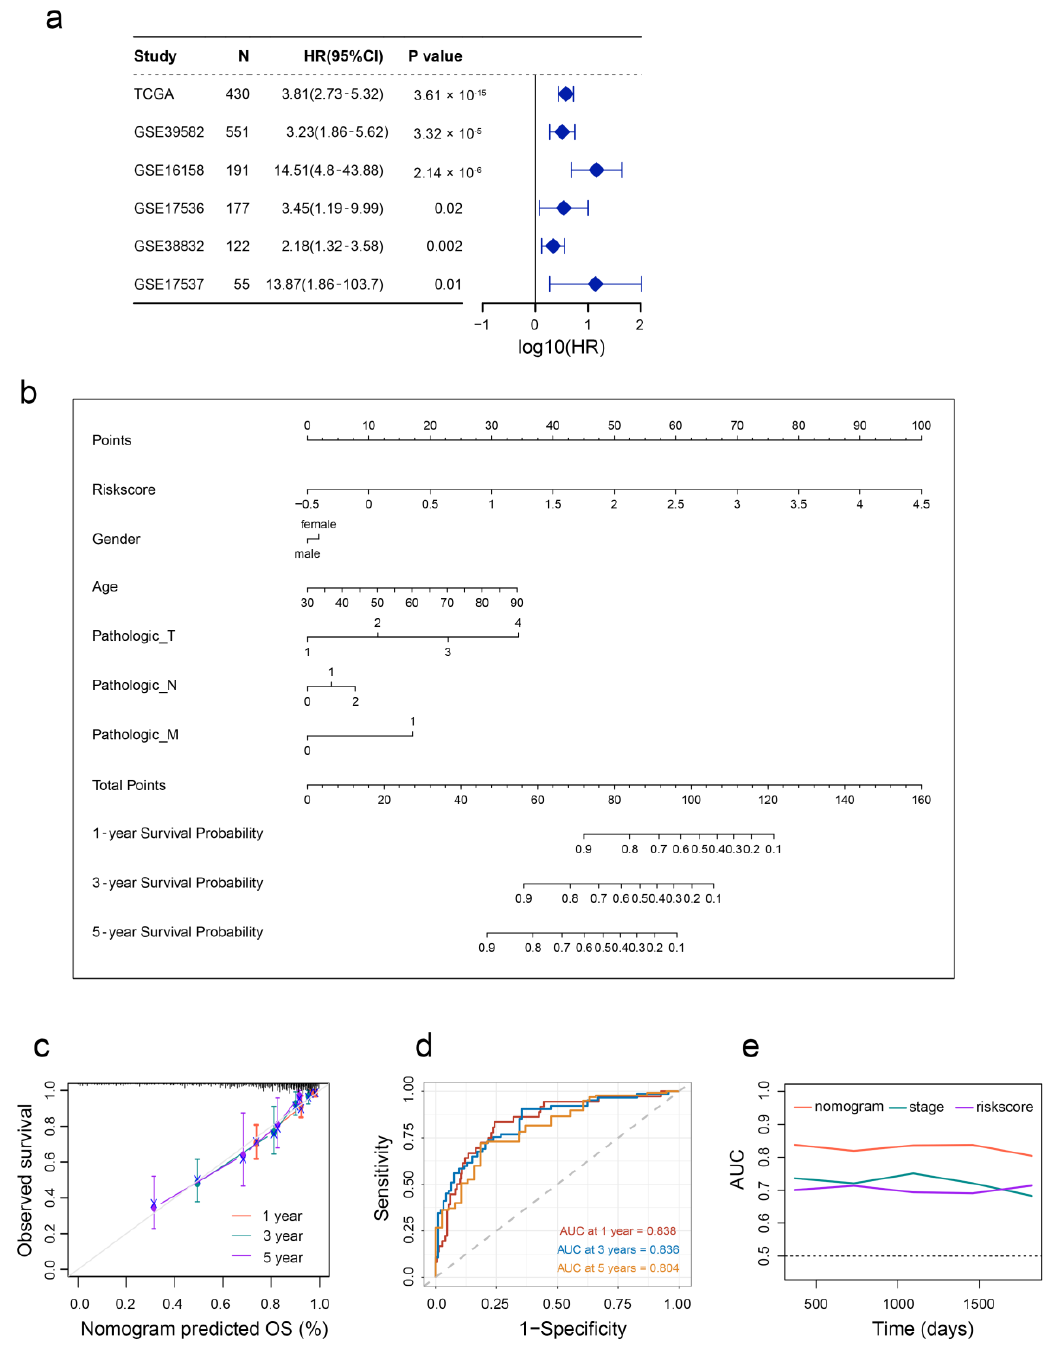
Figure 6. Developed nomogram to predict the probability of survival in CRC patients. ( a ) Univariate Cox regression analyses of risk scores in multiple independent cohorts. ( b ) Prognostic nomogram based on risk scores and clinicopathological characteristics in CRC patients. ( c ) Calibration curves. ( d ) Time-dependent ROC curves at 1, 3 and 5 years. ( e ) Line graph of the area under the curve.